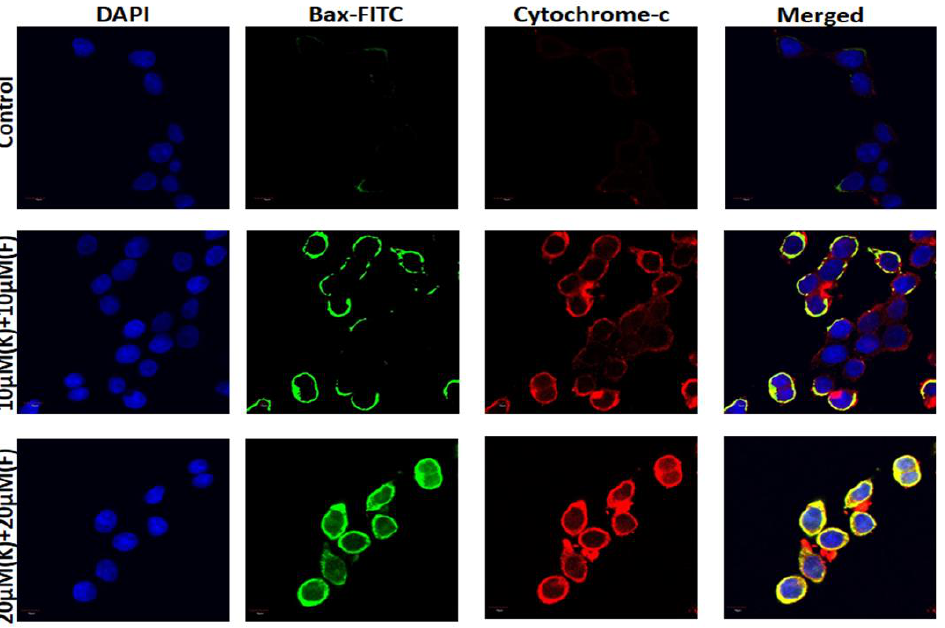
Figure 6. Expression of Bax and cytochrome c after treatment with 10 and 20 μM (K + F) against MDA-MB-231 cells after 24 h by confocal microscopy; DAPI was used as nuclear stain.